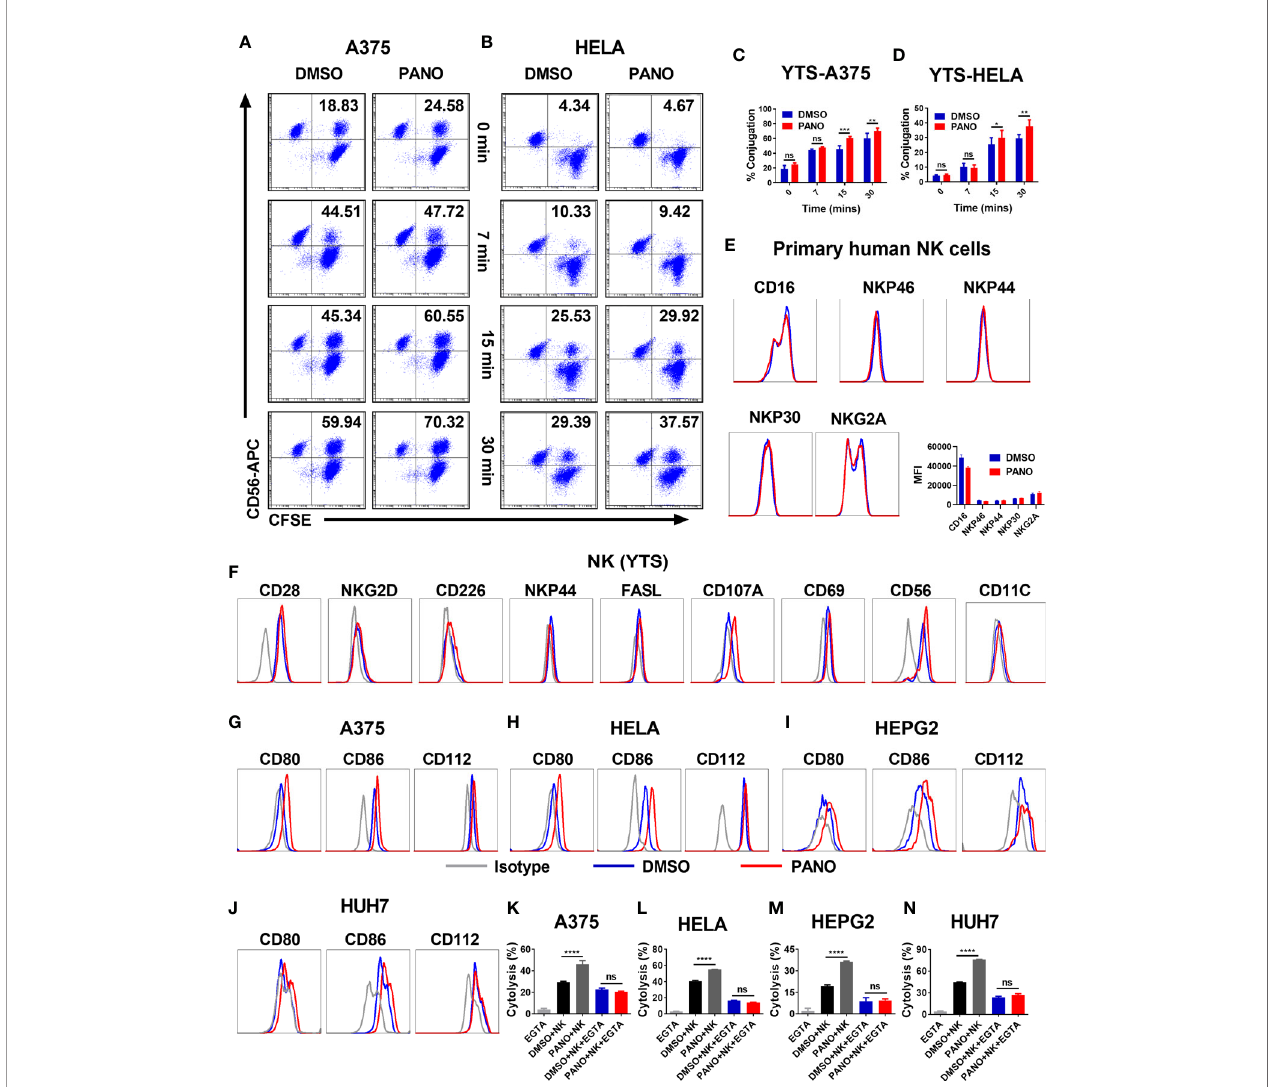
FIGURE 4 | HDACi (Panobinostat) pretreatment promotes NK cell-target cell conjugation formation and modulates the expression of NK cell-activating receptors. Tumor cells were treated with 50nM Panobinostat or DMSO for 24 hours, labeled with CFSE prior to co-incubation with CD56-APC labeled NK(YTS) cells for the indicated times. Conjugates formation between NK(YTS) and target cells ( A , C A375 cells) and ( B , D Hela cells) are indicated as the double-positive population as assessed by fl ow cytometry. Assessment of primary human NK cells, NK(YTS) and Tumor cells pretreated with 50nM of Panobinostat (Red lines) or DMSO control (Blue lines) before fl ow cytometry assessment of the speci fi ed activating and inhibitory receptors and the corresponding IgG Isotype controls (Grey line). Assessment of surface expression pattern of selected activating and inhibitory receptors on (E) primary human NK cells; (F) NK(YTS) cells; (G – J) Assessment of surface expression pattern of NK cell activating ligands on tumor cells. (K – N) Evaluation of the in vitro NK cell cytolysis of Panobinostat (50nM) or vehicle pretreated tumor cells in the presence of EGTA (a divalent cation chelating agent). (A, B) Representative dot plots, (C, D) Statistical analysis of the conjugates formed at different time points. Percentage conjugation is expressed as mean ± SD (n =3 replicates) from three independent experiments. (K – N) Percentage cytolysis is expressed as the mean value ± SD (n =4 replicates) from three independent experiments. Statistical signi fi cance was assessed by a two-way ANOVA (C, D) and t-test (K – N) . (not signi fi cant ns, P >0.05, *P ≤ 0.05, **P ≤ 0.01, ***P ≤ 0.001, ****P ≤